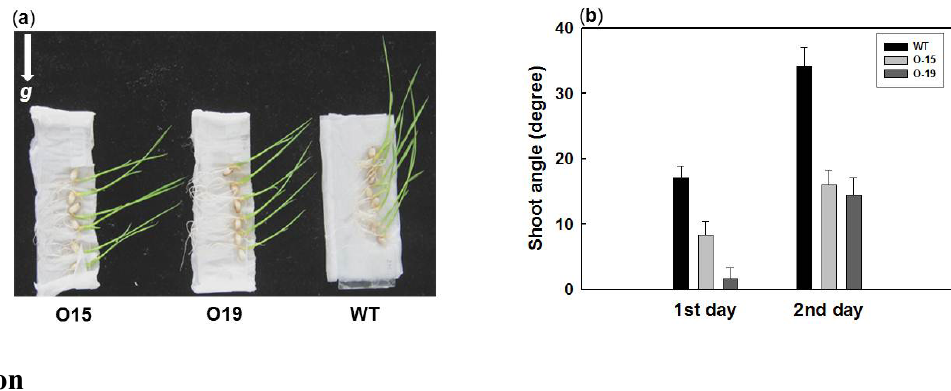
Figure 6. Gravitropism analysis of the OsIAA4 -overexpressing and wild-type plants. ( a ) Three-day-old seedlings of OsIAA4 -overexpressing (O15 and O19) and WT plants were grown vertically for one day and then horizontally grown for another two days. The arrow indicates the direction of gravity; ( b ) The shoot angle of WT and OsIAA4 -overexpressed (O15 and O19) plants on the first day and second day. Values are means ±